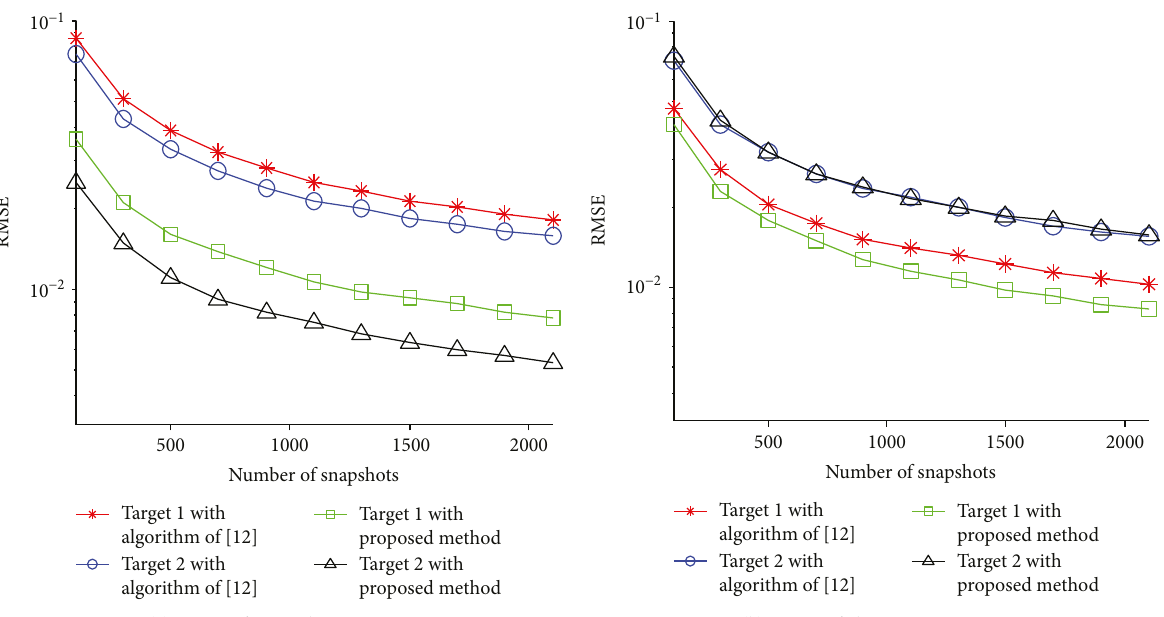
Figure 4: RMSE contrast of two algorithms with di ff erent snapshots.